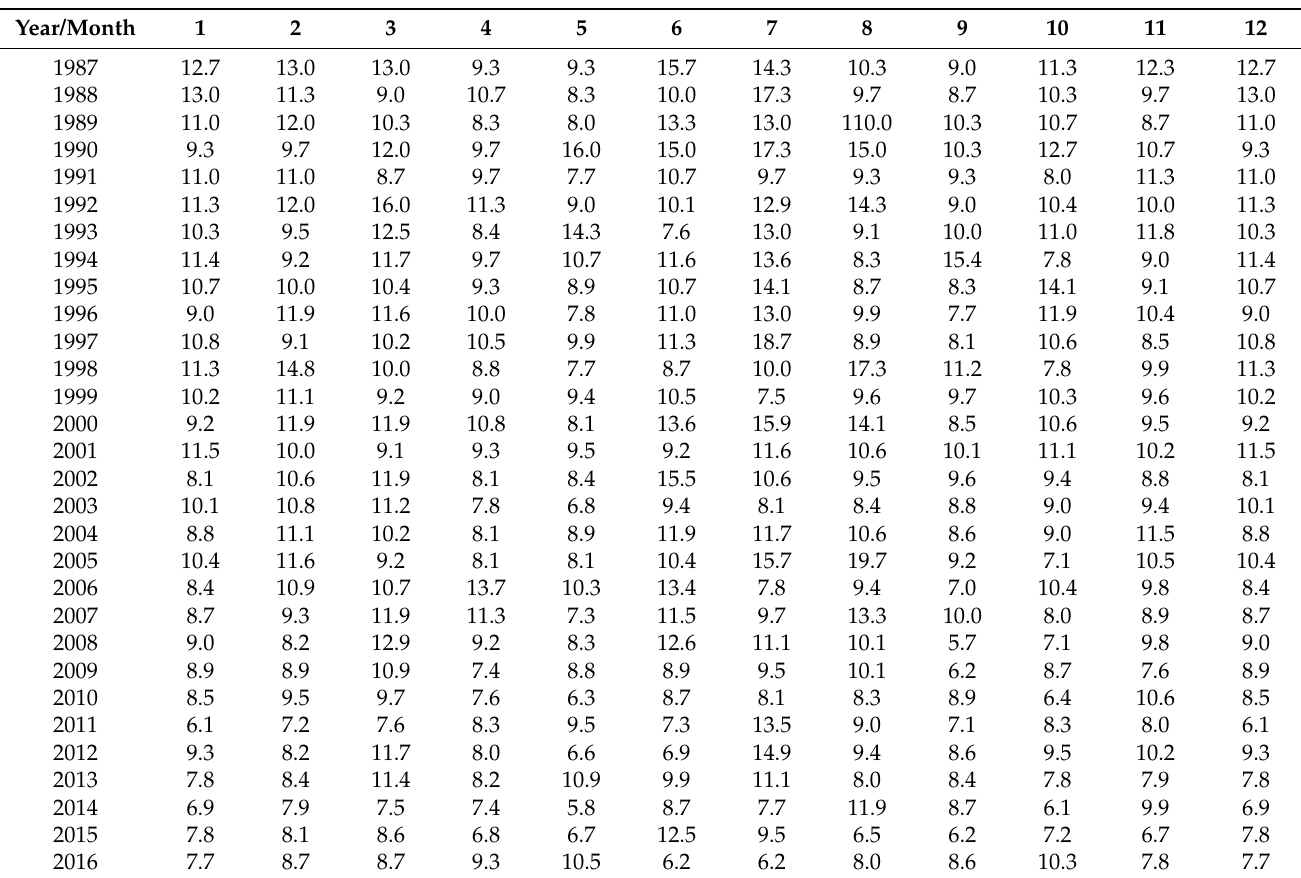
Table 1. Data of maximum wind speed in 30 years